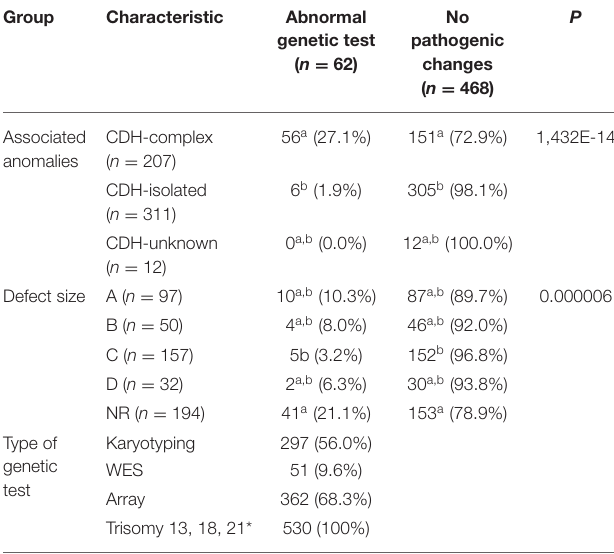
TABLE 4 | Significant differences in output measures of patients with a genetic test.